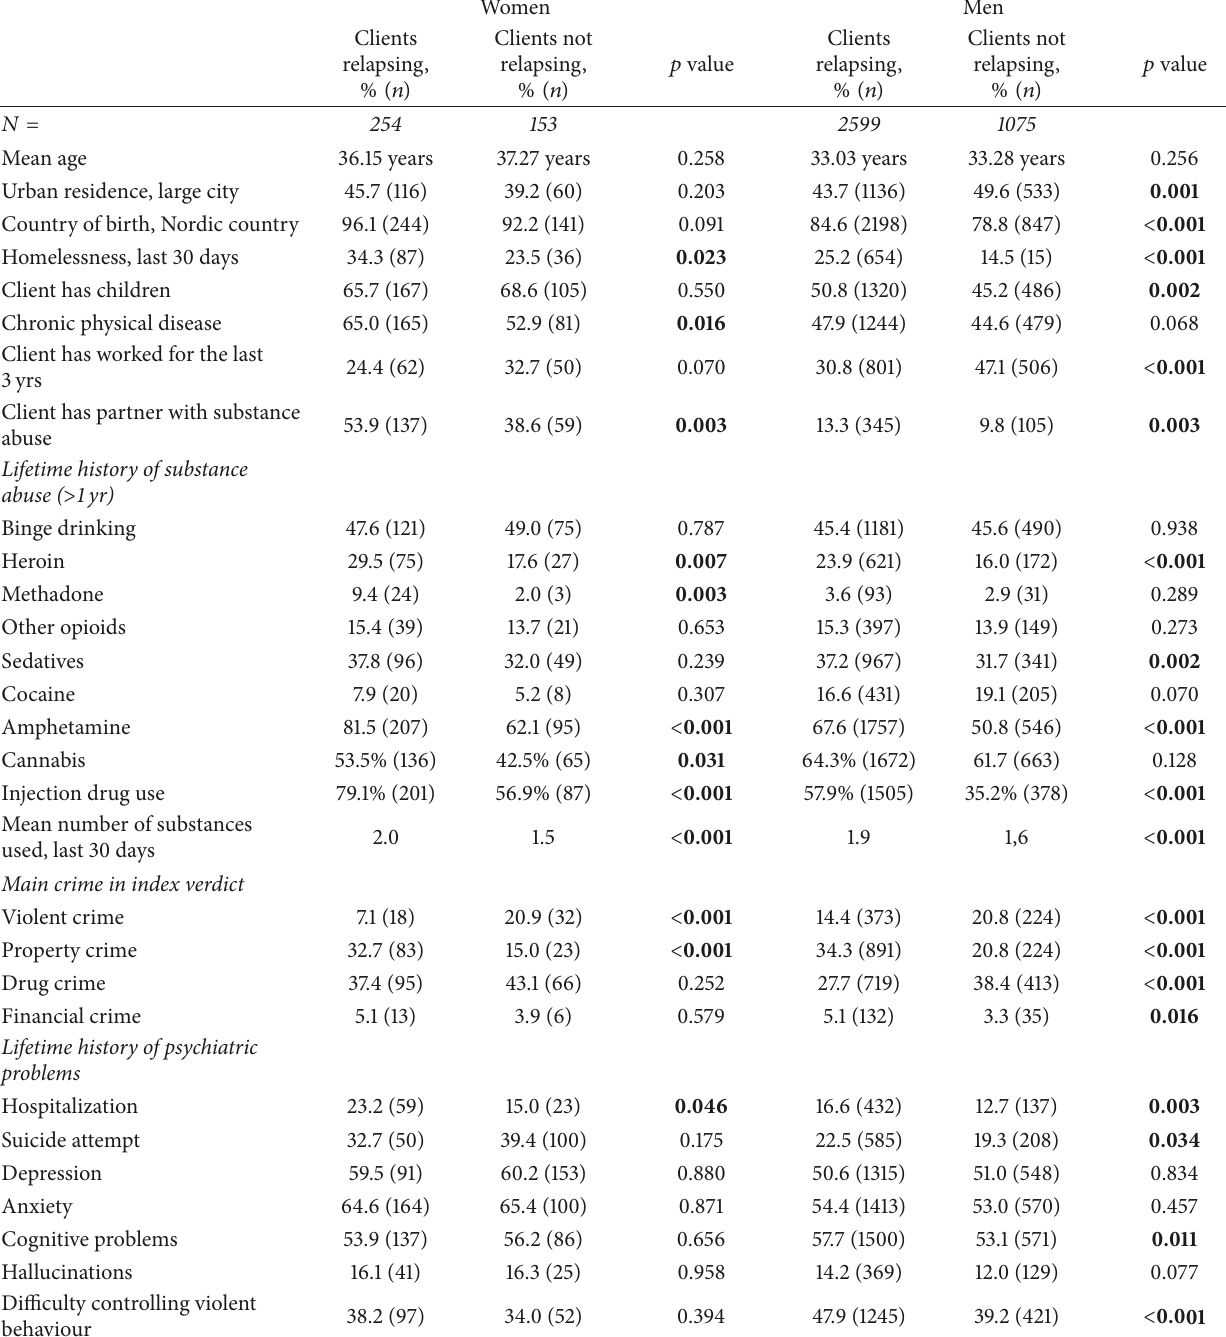
Table 4: Characteristics of clients with and without return to the criminal justice system during follow-up.